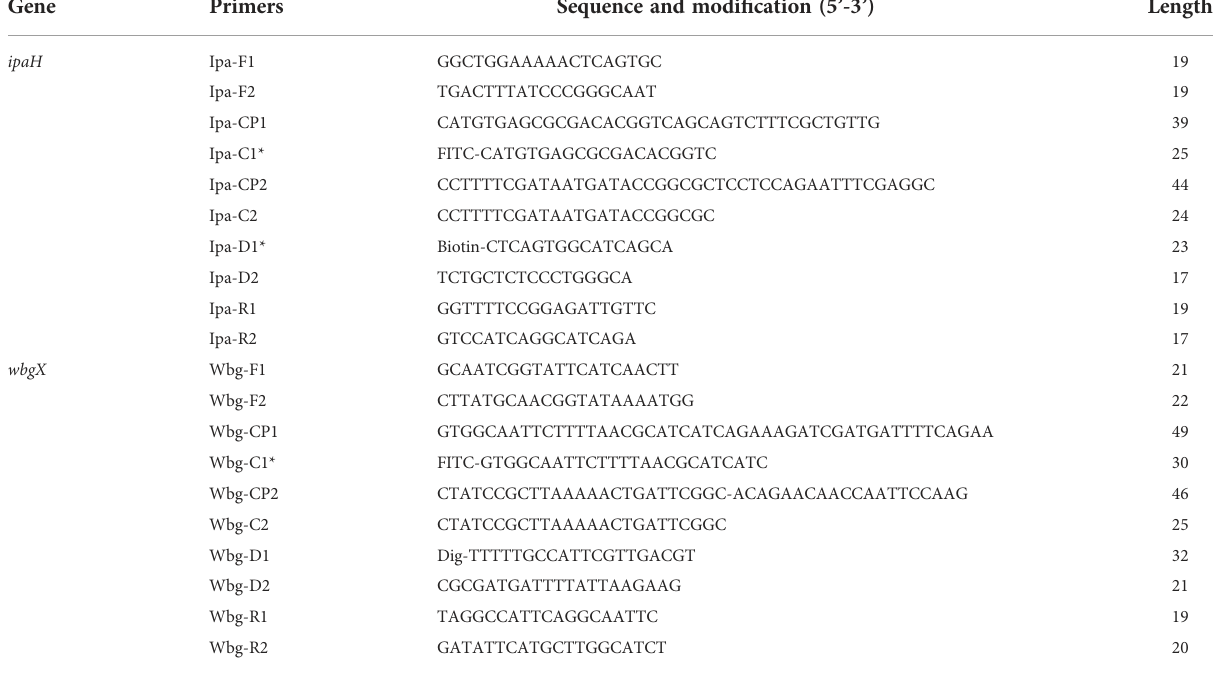
TABLE 2 Primers used in this